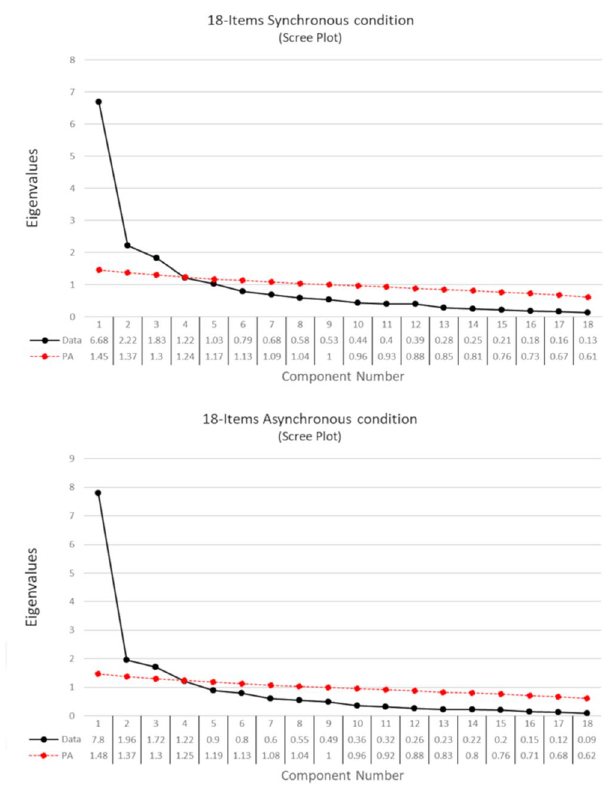
Figure 5. Scree-plots of the PCA on the 18 items selected for the embodiment scale. The upper panel referred to the synchronous stimulation condition, and the lower panel referred to the asynchronous stimulation condition. The eigenvalues of each component are reported in the tables below the respective graph. The black dots represent the eigenvalues of each component in decreasing order. The red line shows the simulated data of the parallel